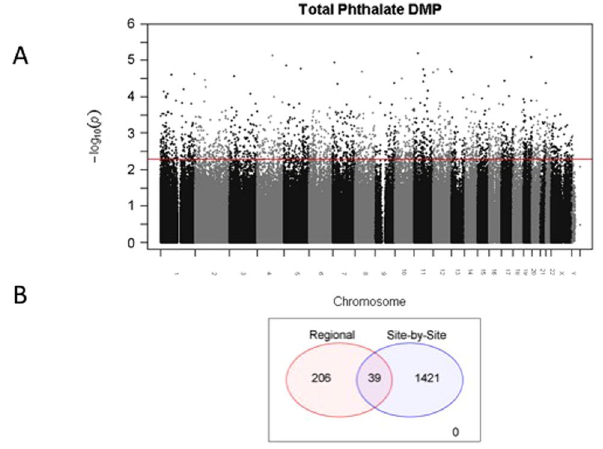
Figure 2. ( A ) Manhattan plot for the DMP analysis. The red line represents the p-value threshold of 0.005 applied to get our candidate list. All CpG probes that lie above this line are considered significant. ( B ) Ven diagram illustrating the overlap of differentially methylated probes (DMP) and differentially methylated region (DMR) analysis.